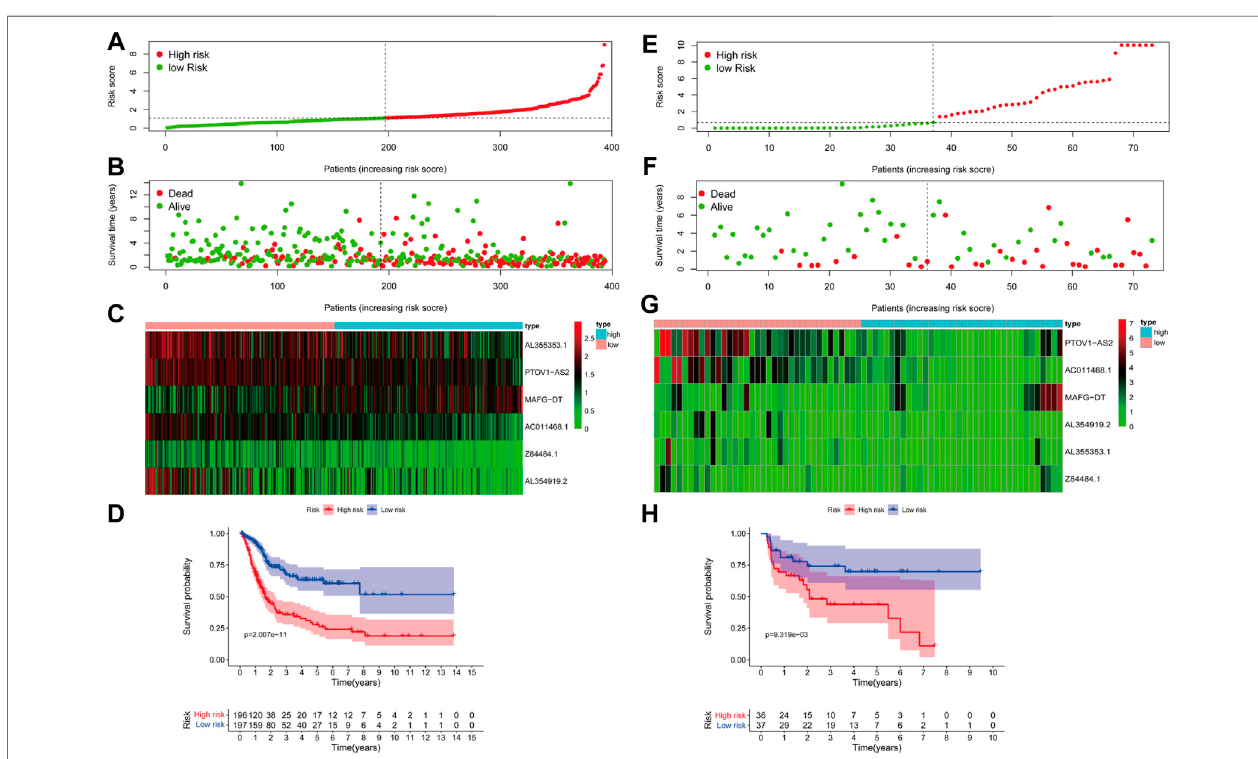
FIGURE 3 | The accuracy of the prognostic model in training and testing cohort. (A) The distribution of risk score in TCGA BLCA cohort. (B) The survival status of high- and low-risk groups in TCGA BLCA cohort. (C) The expression ofthe 6 glyco-lncRNAs between the high- and low-risk groups in TCGA BLCA cohort. (D) Kaplan- Meiersurvivalcurveofthehigh-andlow-riskgroupsinTCGABLCAcohort. (E – H) Thedistributionofriskscore,survivalstatus,expressionstatusofthe6glyco-lncRNAs and Kaplan-Meier survival curve of the high- and low-risk groups in GSE154261